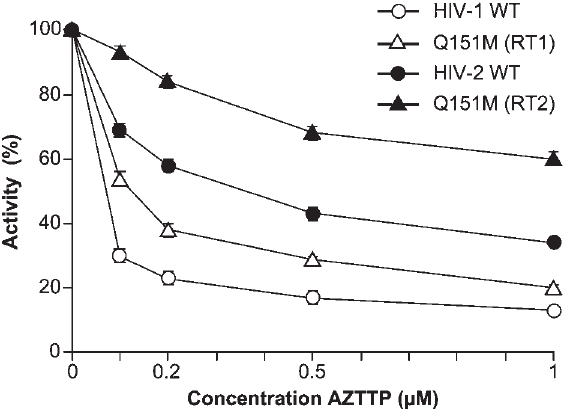
Figure 2. Inhibition of RT Polymerization by